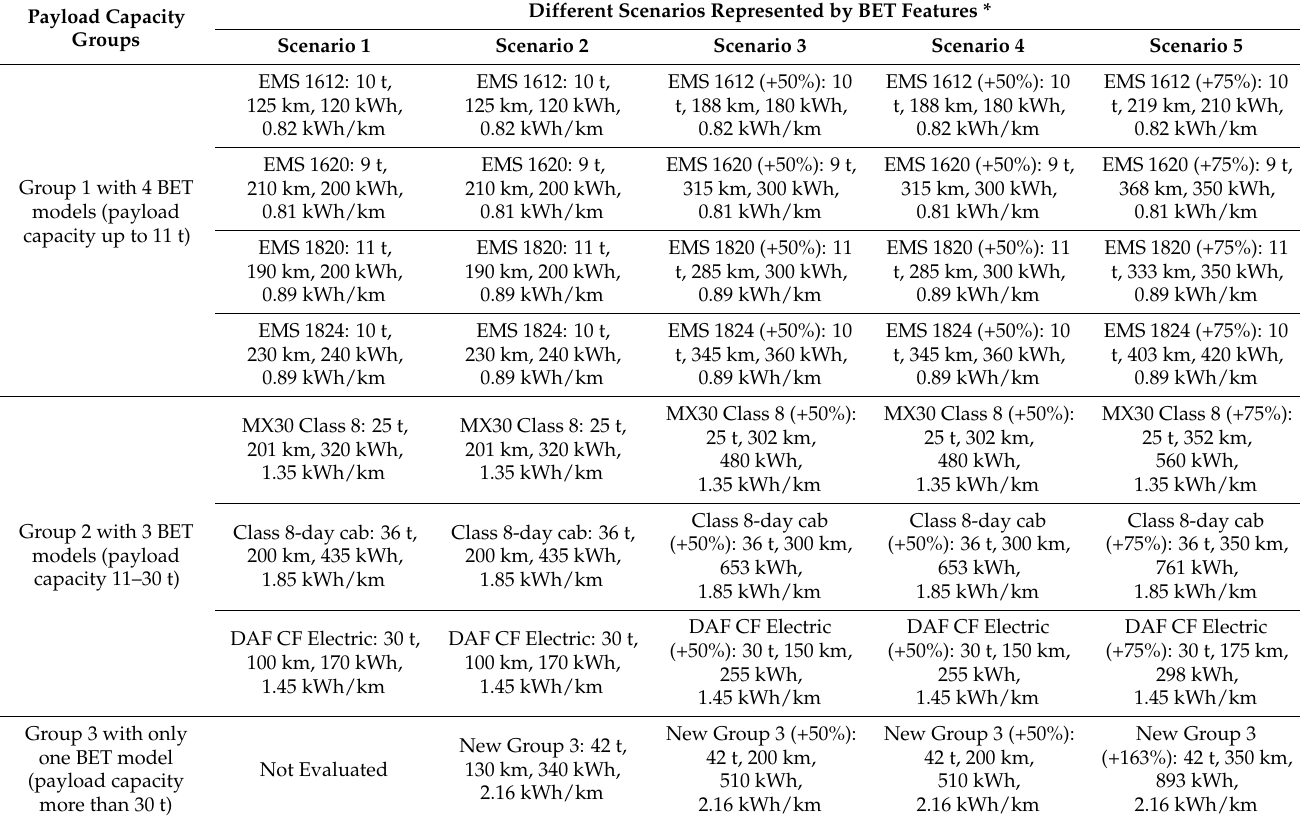
Table 3. Battery electric truck (BET) features per group for battery electric vehicle potential (BEVPO) model simulation